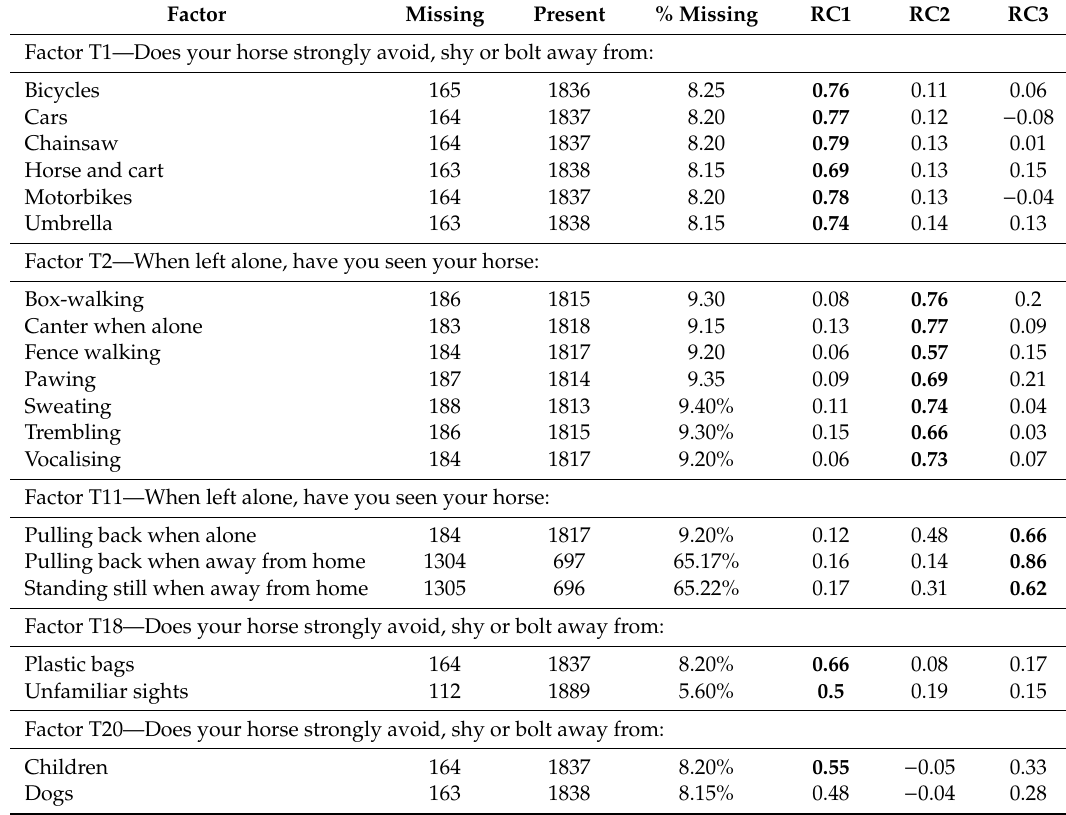
Table 1. Equine Behaviour Assessment and Research Questionnaire (E-BARQ) items in the five factors of interest for trait selection after rotation to facilitate interpretation. “T” represents the temperament factor from factor analysis (T1, T2, T11, T18, T20) and “RC” is the rotated component (RC1, RC2 and RC3). This parallel analysis suggested three underlying components with loadings as follows. Significant loadings are in